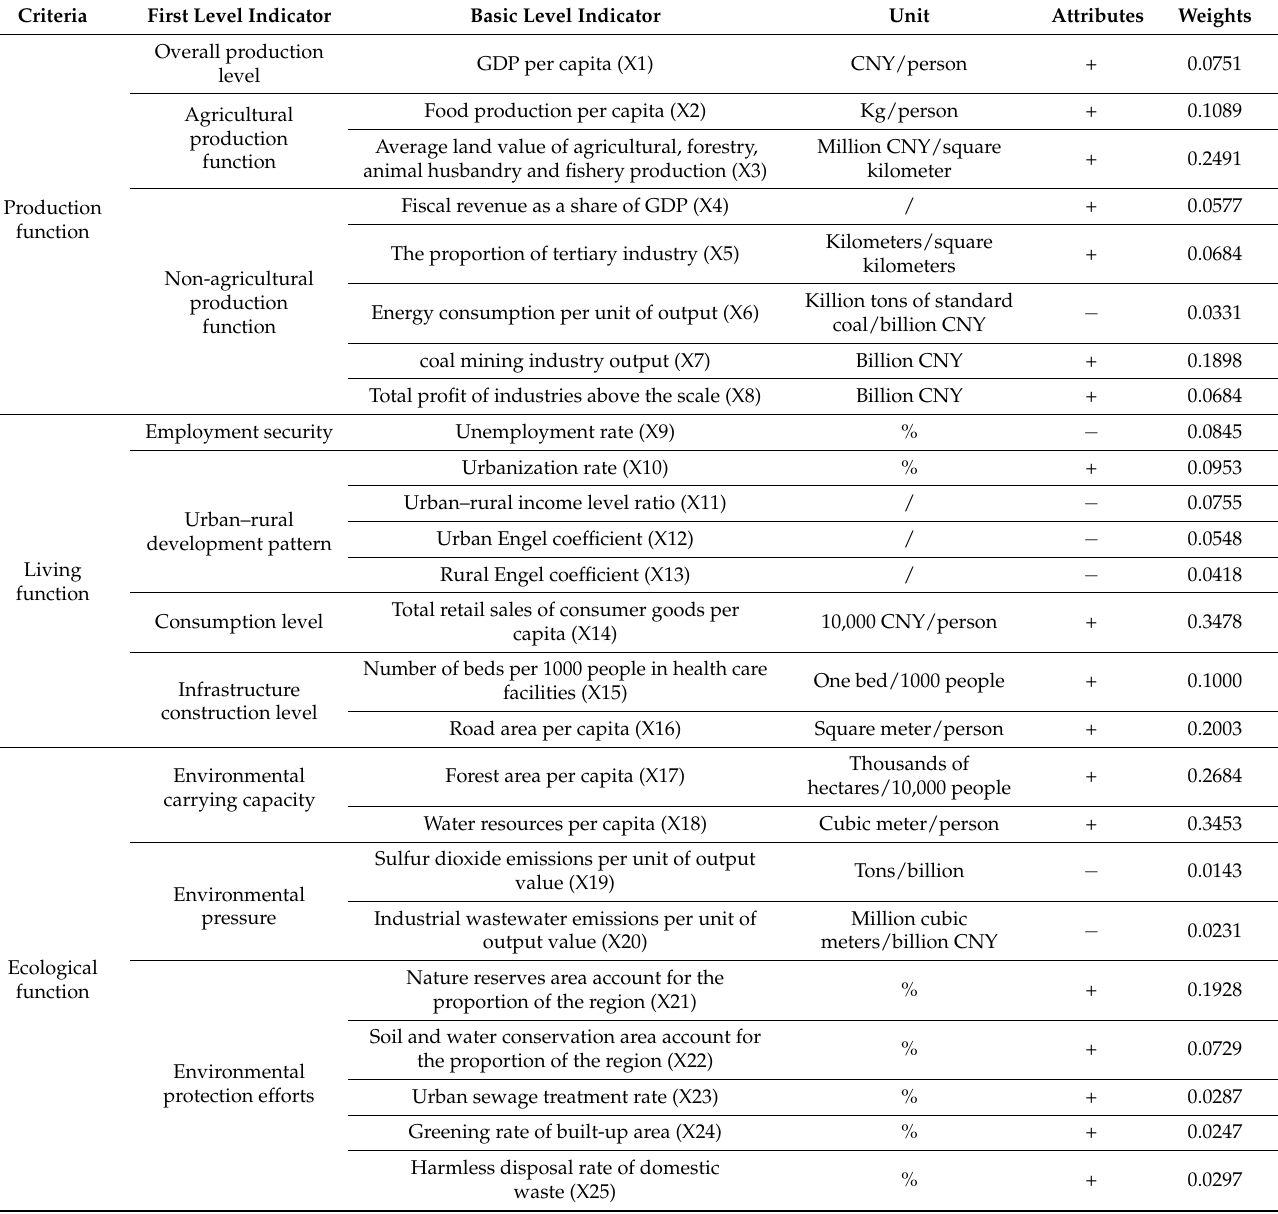
Table 1. Functional evaluation index system of “production-living-ecological” function in the Yellow River